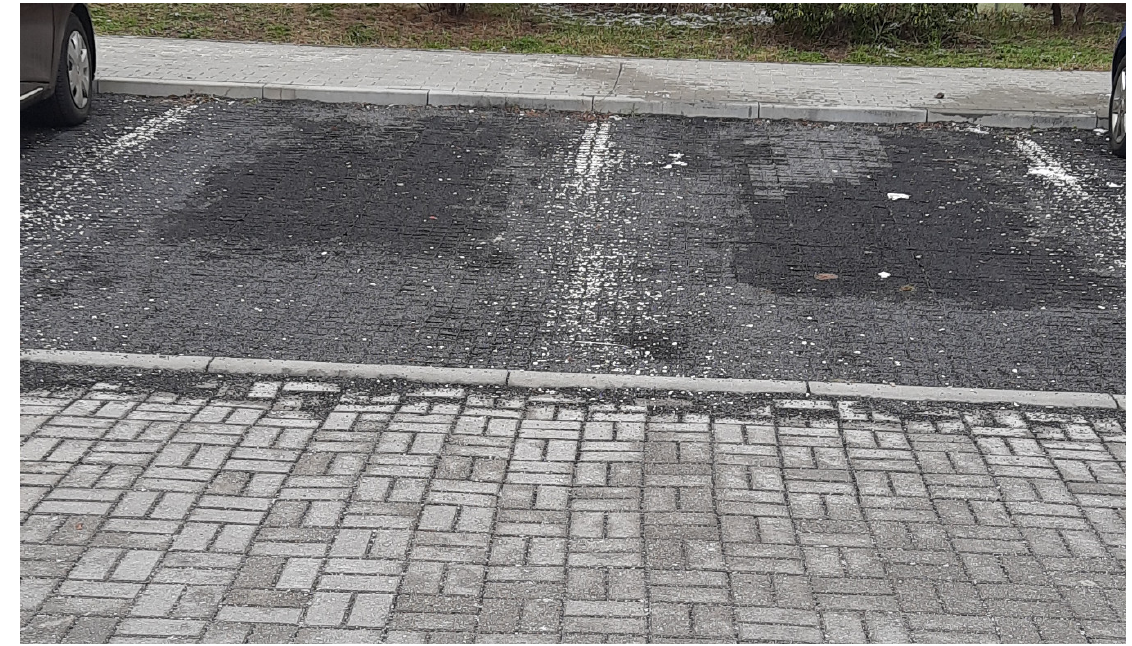
Figure 1. Example of rainwater permeable parking places—Zielona Góra, Cisowa Street.